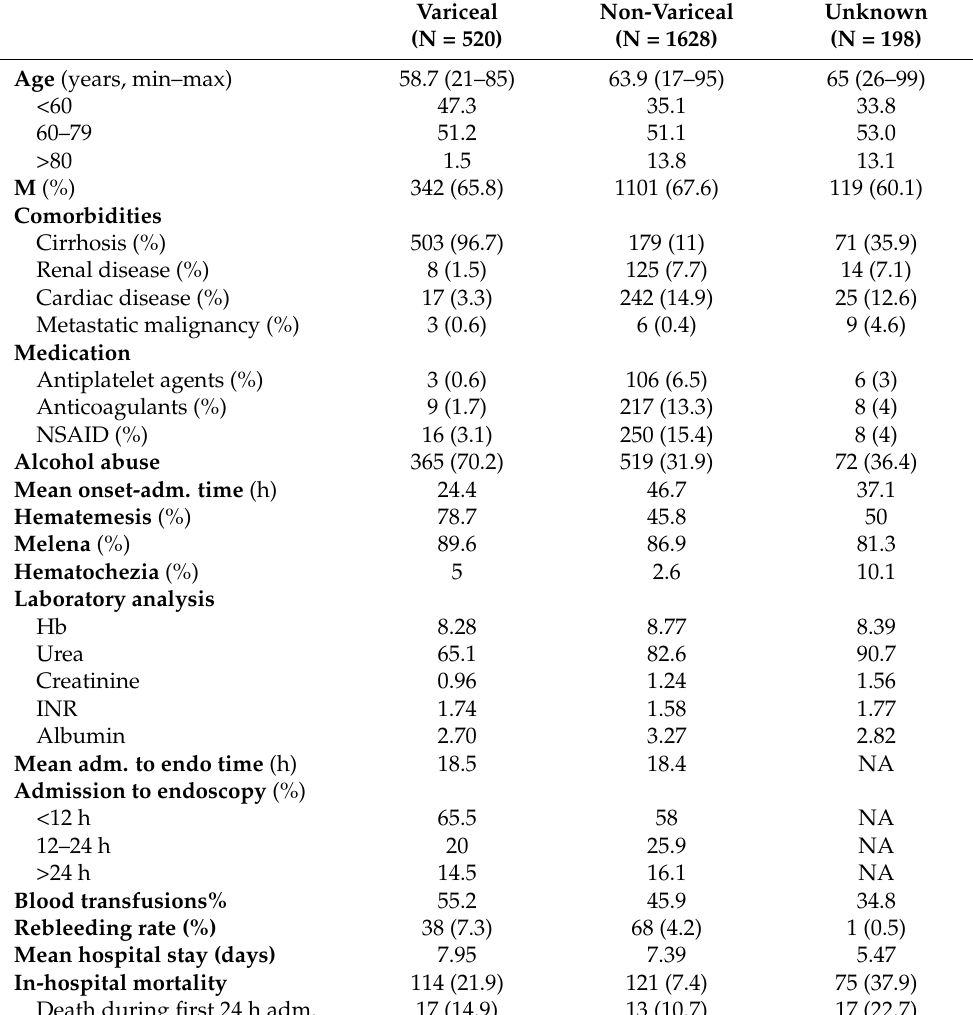
Table 11. Main characteristics of patients with unknown etiology (no endoscopy) compared with VUGIB and